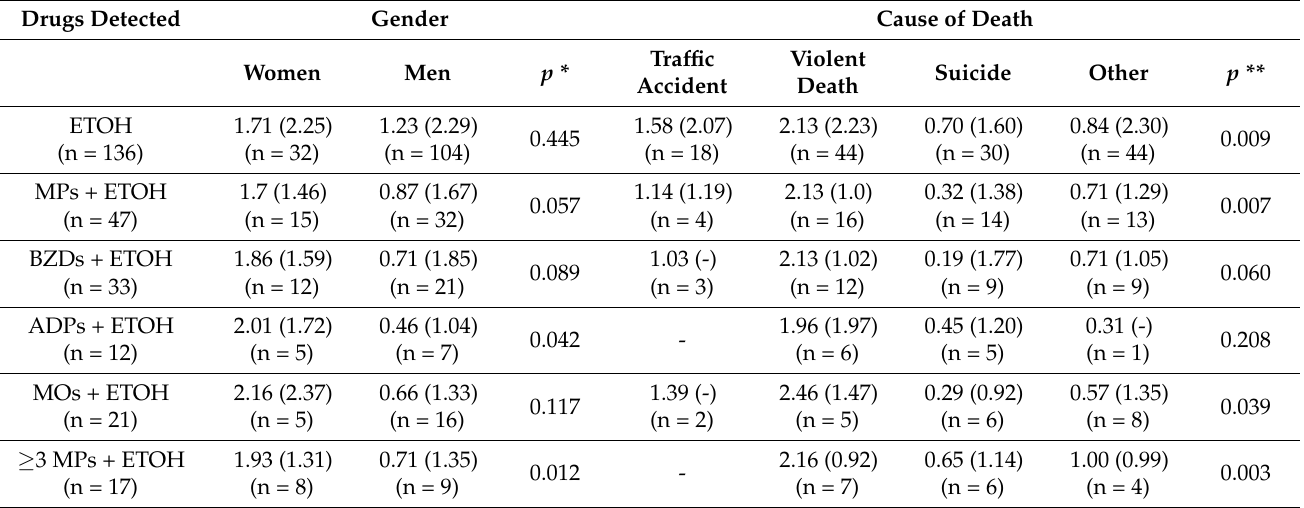
Table 3. Median (and interquartile range) of blood alcohol concentrations (BAC) in g/L in relation to type of legal psychotropics detected and sociodemographic and forensic characteristics.